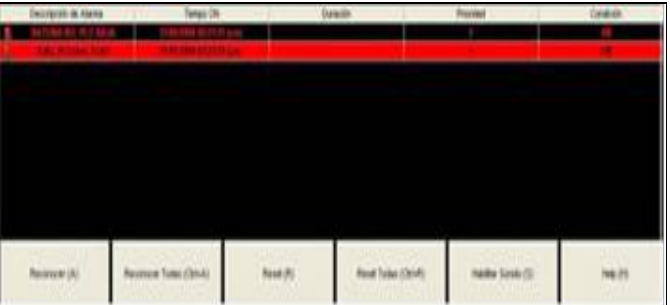
Figura 8: Pantalla de alarmas. Fuente: Los Autores, (2018).